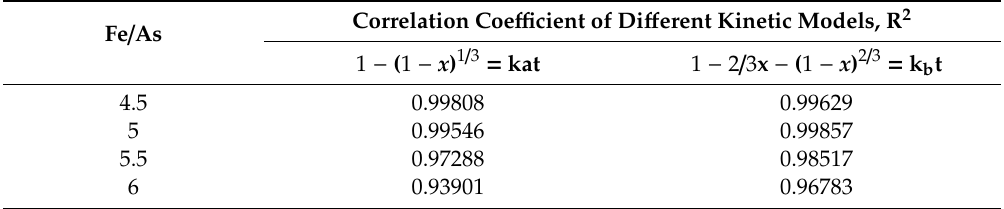
Figure 8. Arsenic removal kinetics at different molar ratios of iron to arsenic.